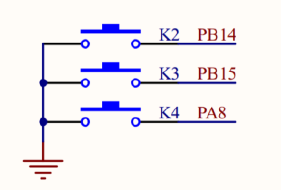
Fig. 7 . The circuit diagram of LCD1602.